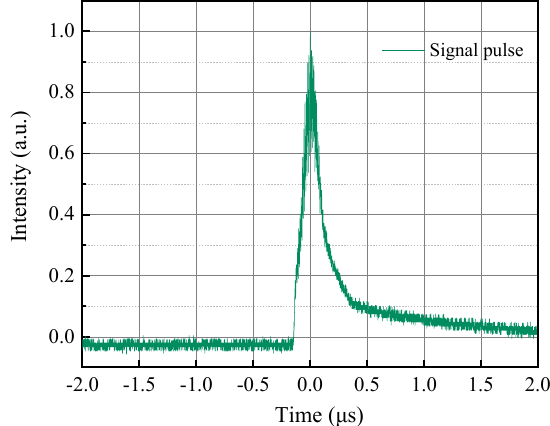
Figure 6. The signal pulse profile with a pulse duration of 120 ns.